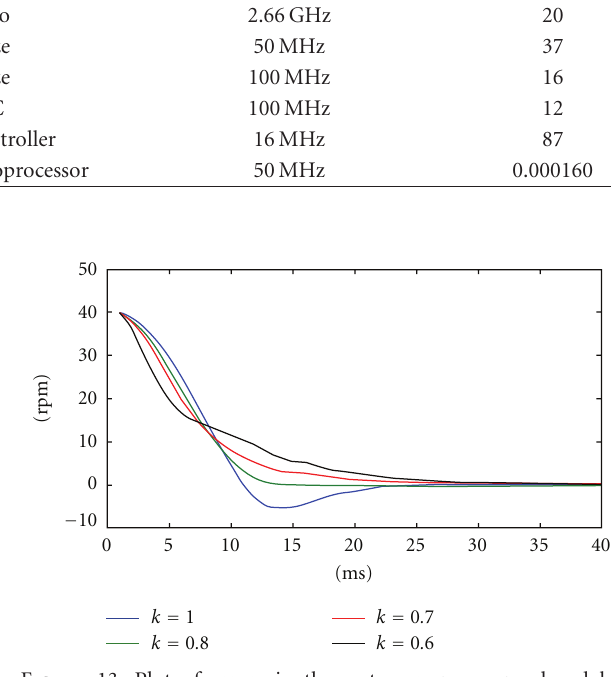
Figure 12: System response for di ff erent tuning factors. Figure 13: Plot of errors in the system response produced by di ff erent k tuning values. Note that k = 0 . 8 produces less